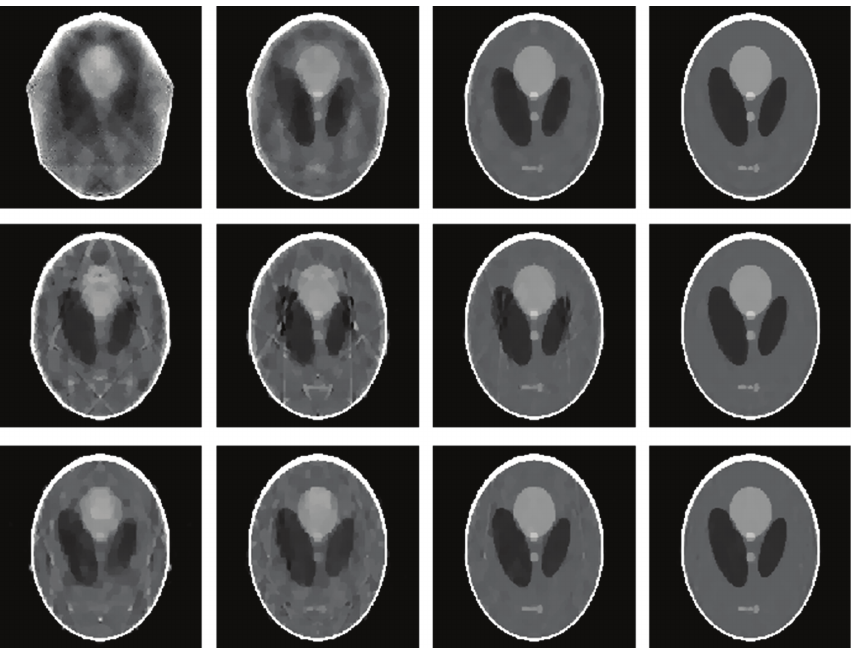
Figure 3: Reconstructed images from noise-free projections after 5000 iterations. Form the left to right columns, the projection numbers are 9, 11, 13 and 15, respectively. From the top to bottom rows, the source numbers are 1, 2, and 3, respectively. The display window is [0,0 . 5].